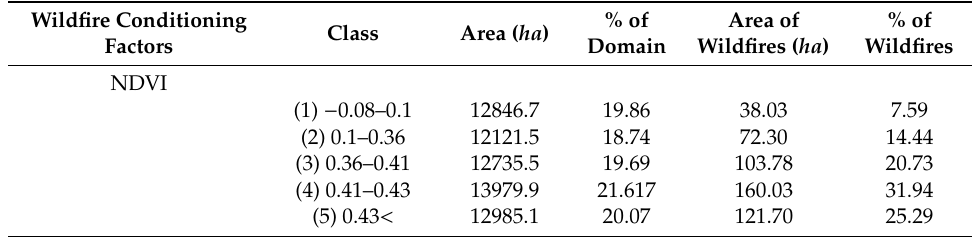
Table 5. The normalized di ff erence vegetation index (NDVI), the area of classes, and percent of the wildfire-a ff ected areas in each class.